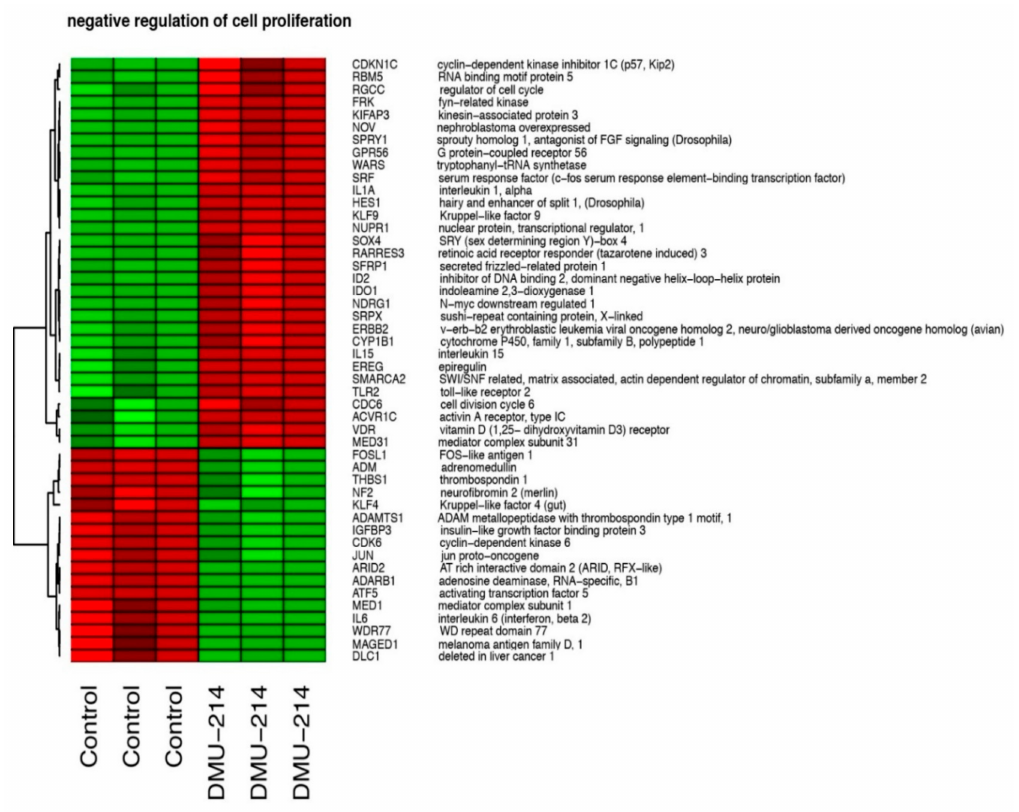
Figure 6. Heat map graph of di ff erentially expressed genes belonging to “negative regulation of cell proliferation” GO BP term. Arbitrary signal intensity acquired from the microarray analysis is represented by colours (green—higher; red—lower expression in relation to control). Log2 signal intensity values for any single gene were resized to Row Z-score scale. Gene symbols and gene names of di ff erentially expressed genes were shown.